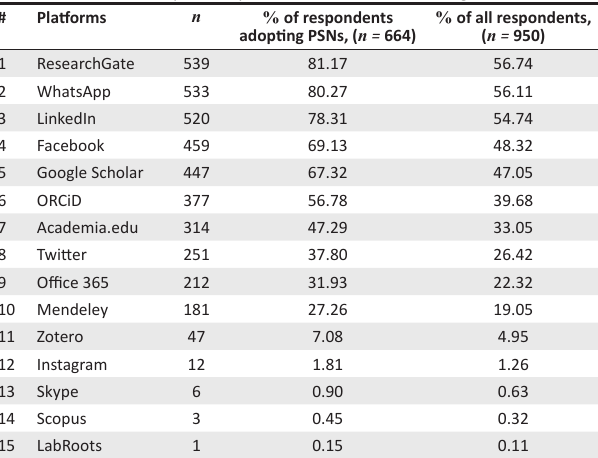
TABLE 1: Platforms adopted for professional social